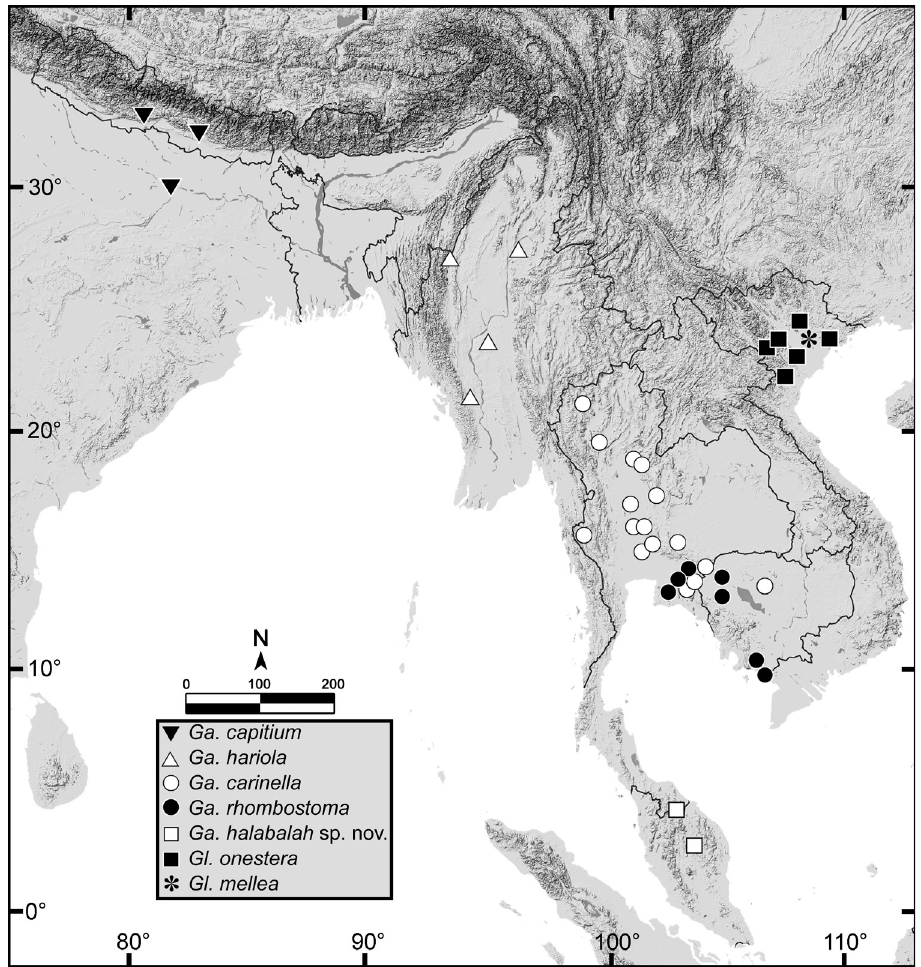
Figure 8. Geographic distribution of Ganesella spp. and Globotrochus